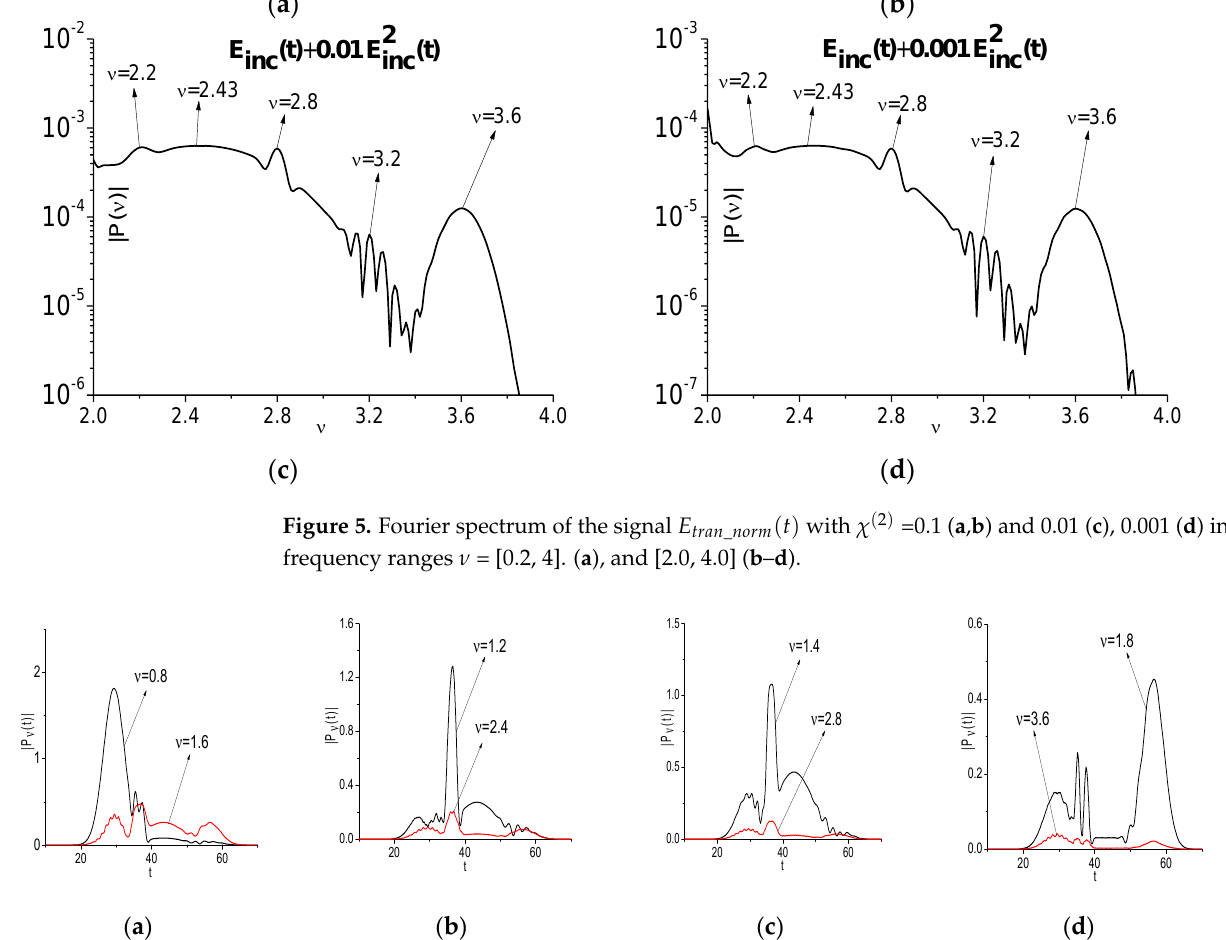
Figure 13. Fourier spectra of the PWM_40 first sub-pulse ( a ) and reference ( b ) in the frequency range ν = [1.8, 6.2] THz in the logarithmic scale along the abscissa axis.